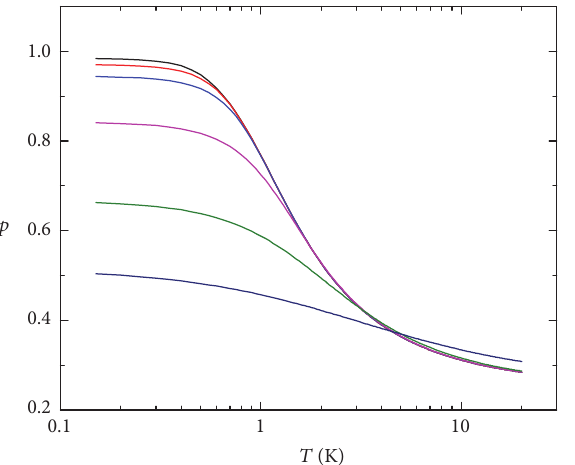
Figure 9: Temperature dependencies of the exponent 𝑝 for different 𝑛 values. From top to down, 𝑛 = 200, 100, 50, 15, 5, and 2, respectively.